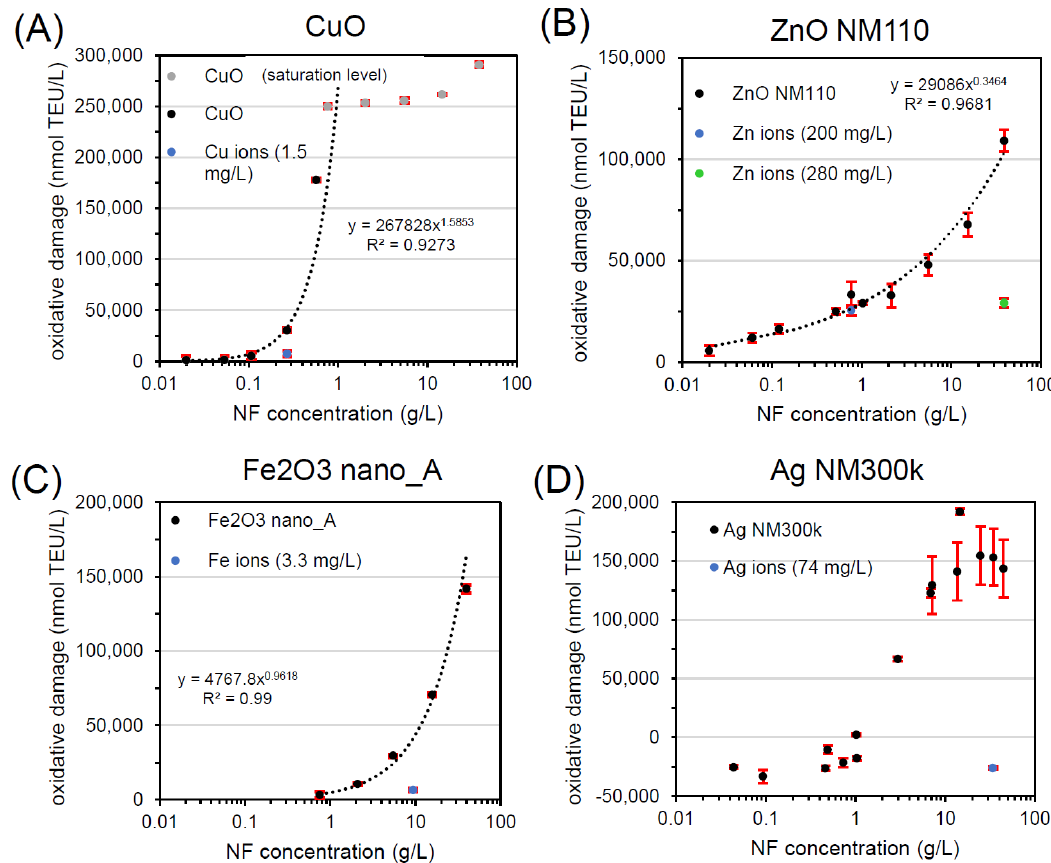
Figure 2. Workflow implementation with FRAS testing ( A ) CuO, ( B ) ZnO NM110, ( C ) Fe 2 O 3 nano_A, and ( D ) Ag NM300k. All curves represent dose-response data of particles (black, grey) and of ions (blue, green). TEU, Trolox equivalent unit (mM).